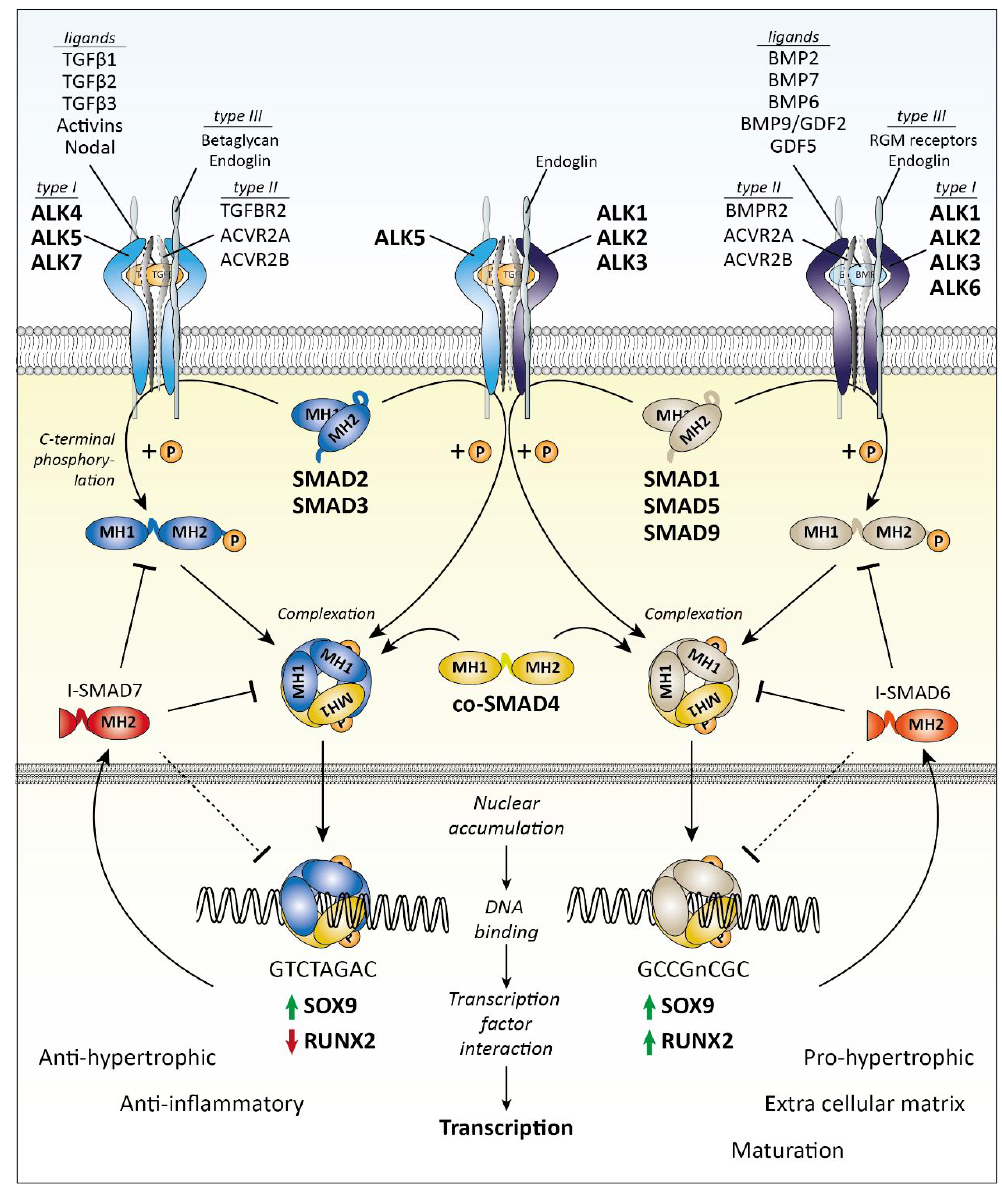
Figure 2. Transforming growth factor β (TGF β ) family SMAD-dependent signaling. Ligand binding